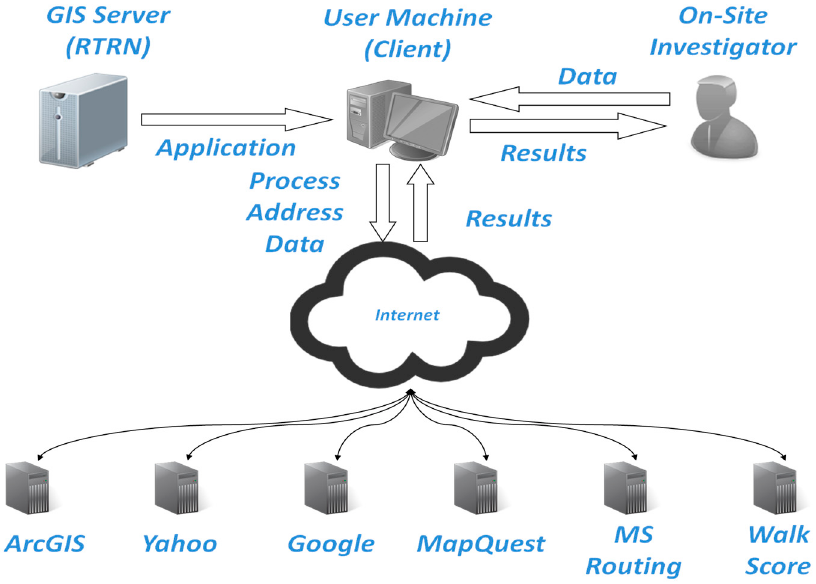
Figure 1. Architectural design of the GIS application.